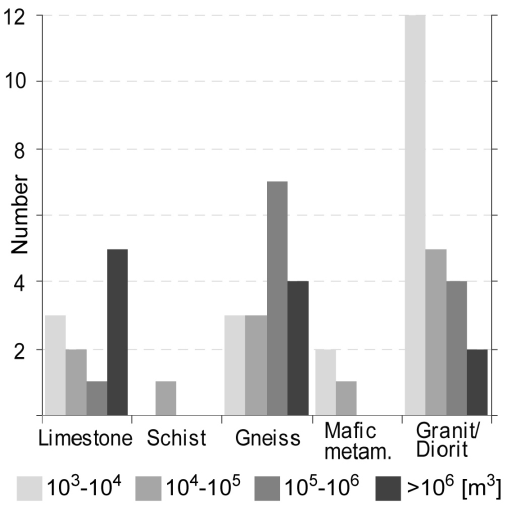
Fig. 9. Number of events of a particular volume class within the different